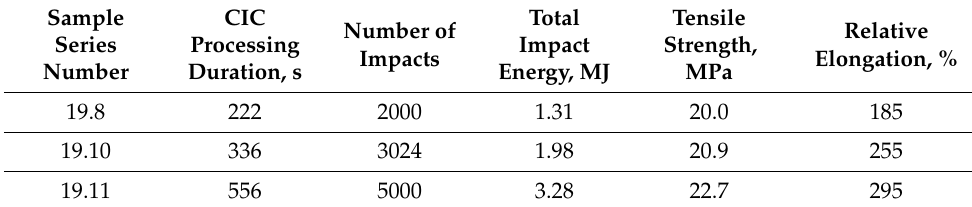
Table 2. Compacting UHMWPE powder with a different number of